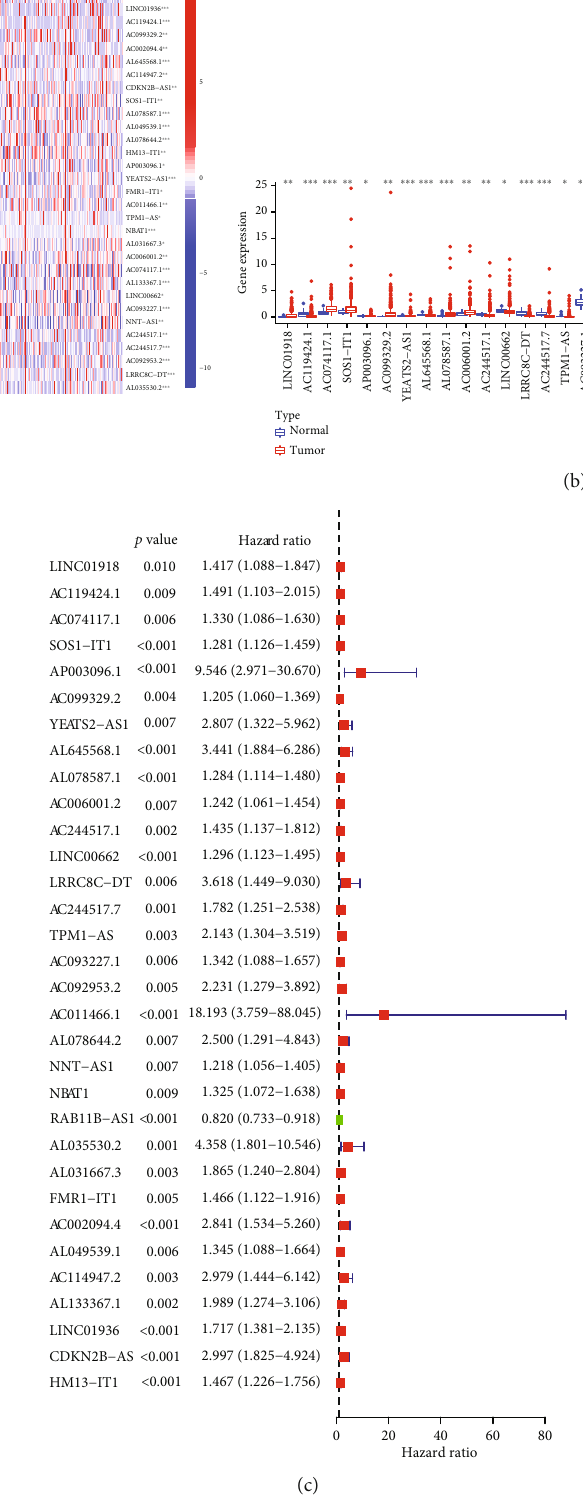
Figure 2: Univariate Cox regression analysis identi fi ed 36 prognostic N6-methyladenosine- (m6A-) relevant long noncoding